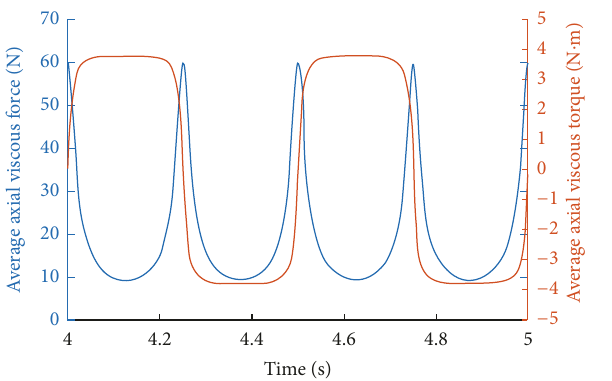
Figure12:Viscousforceandtorqueofdrillingpipesintimedomain.